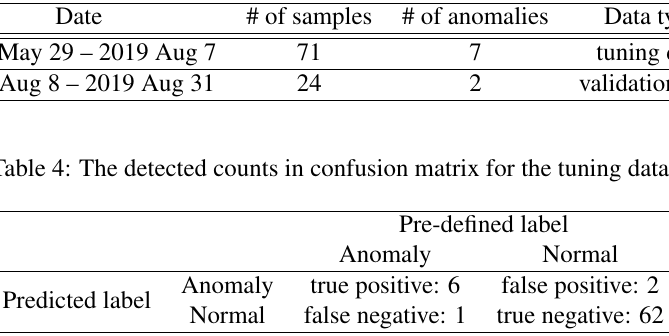
Table 3: The definition of data for performance studies using the DPM logs.